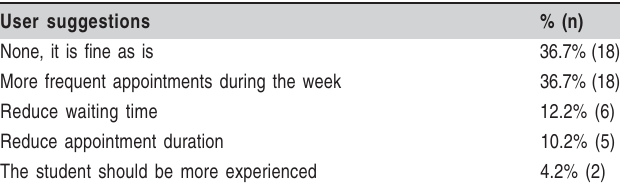
Table 4 – Patient suggestions to improve dental service at